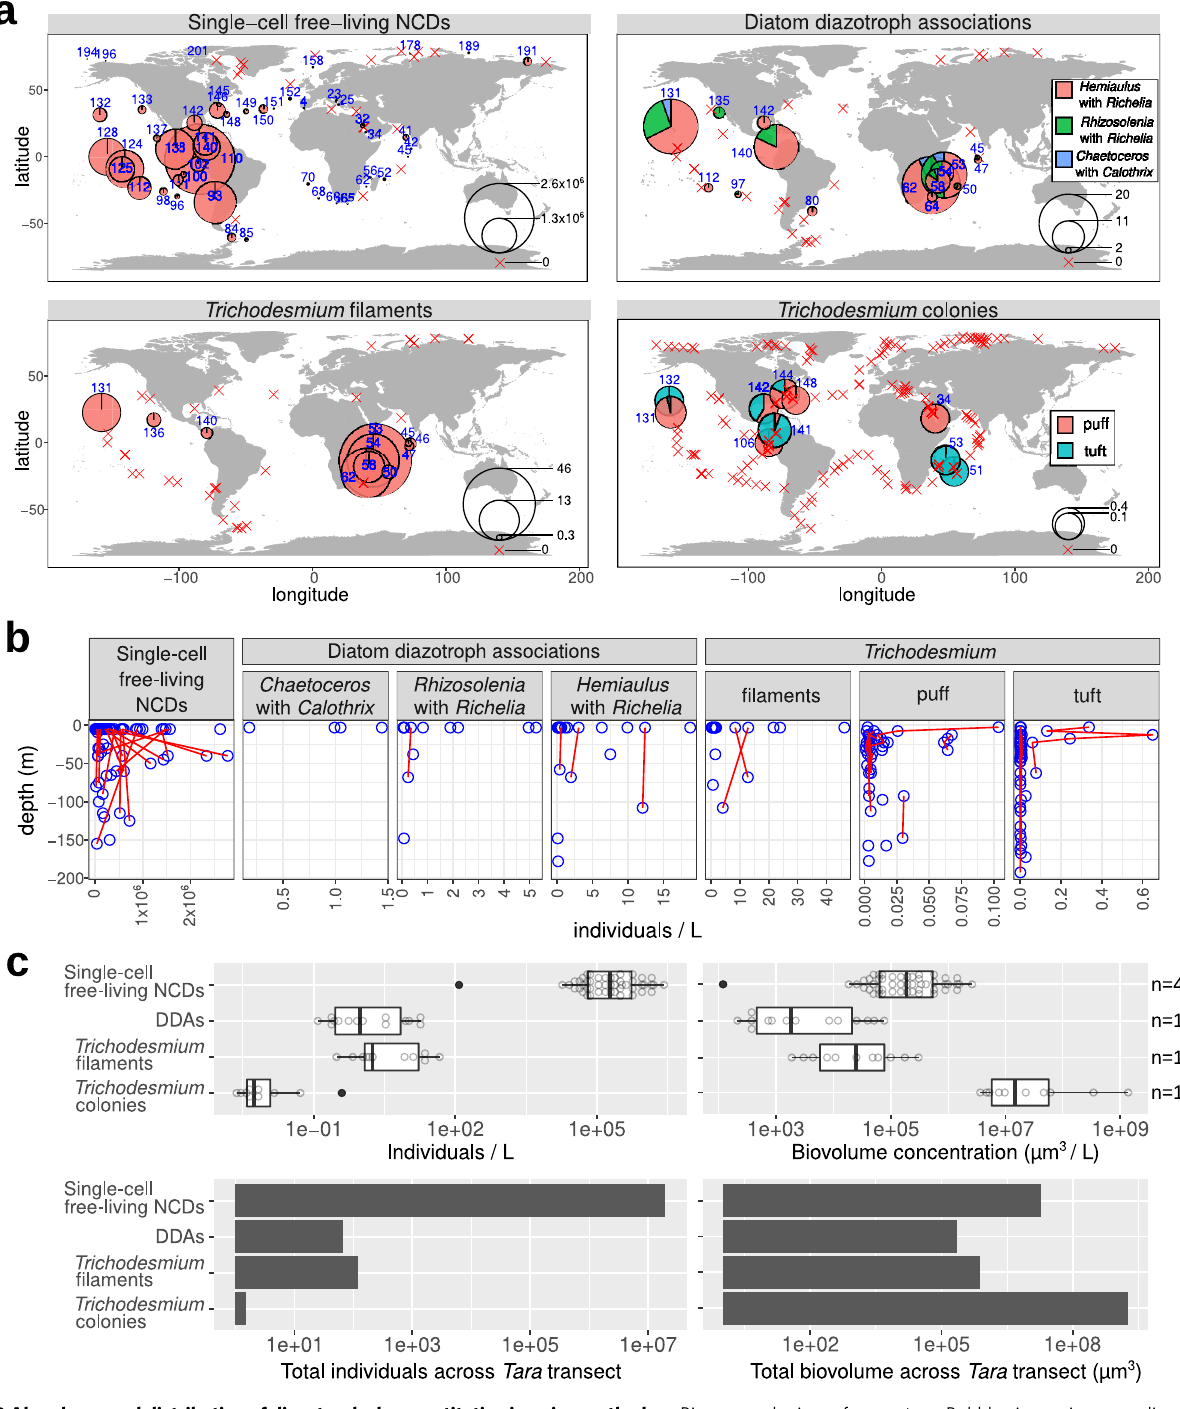
Fig. 3 Abundance and distribution of diazotrophs by quantitative imaging methods. a Biogeography in surface waters. Bubble size varies according to the corresponding diazotroph concentration (individuals/L), while red crosses indicate their absence. Station labels with detection of diazotrophs are indicated in blue. b Depth partition. Samples from the same geographical site are connected by red lines. c Distribution of individual abundances and biomass in surface waters. Single-cell free-living non-cyanobacterial diazotrophs (NCDs) were quanti fi ed by merging fl ow cytometry counts with nifH / recA ratio from metagenomes from size fraction 0.22 – 1.6/3 μ m and assuming an average cellular biovolume of 1 μ m 3 based on the cell dimensions reported in the literature for cultured NCDs 102 – 107 . The detection and biovolume determinations of diatom-diazotroph associations (DDAs) and Trichodesmium -free fi laments were carried out by high-throughput confocal microscopy in samples from the 20 – 180 μ m size fraction. In the case of Trichodesmium colonies, it was determined using in situ images from the UVP5. Boxplots depict the 25 – 75% quantile range of the dataset without zeros (the corresponding biologically independent seawater samples are indicated in the plot), with the center line depicting the median (50% quantile); whiskers encompass data points within 1.5× the interquartile range. Source data are provided as a Source data fi le.